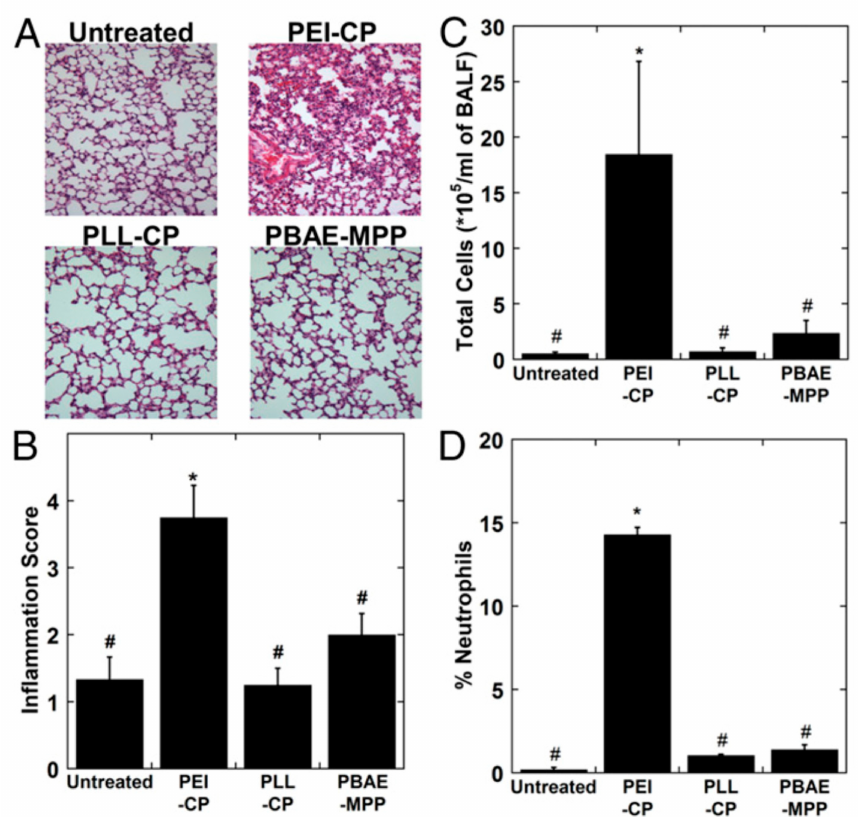
Figure 6. In vivo safety profile of DNA-NPs. ( A ) Representative images of lung parenchyma 24 h after administration of DNA-NPs. ( B ) Histopathological scoring of lung inflammation. (C and D) Total cell counts ( C ) and % neutrophils ( D ) in bronchoalveolar lavage fluid following a single administration of DNA-NPs. Data represent the mean ± SD (n = 3–5). The di ff erences are statistically significant ( p < 0.05) compared with untreated control (*) or mice dosed with Conventional PEI nanoparticles (PEI-CPs) (#). Adapted with permission from Reference